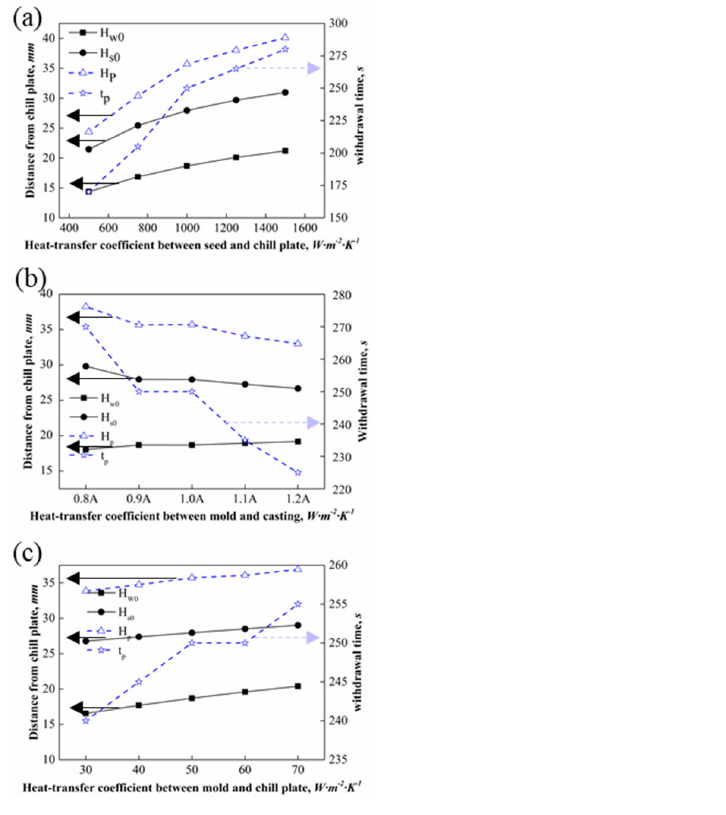
Figure 9. The effect of boundary conditions on the thermal profile of the seed segment: ( a ) the influence of heat transfer coefficient between the seed and the chill plate, ( b ) the influence of the heat transfer coefficient between the mold and the casting, and ( c ) influence of the heat transfer coefficient between the mold and the chill plate. H w0 refers to the distance between the liquidus temperature point on the mold (inner surface) and the bottom of the seed at the end of the holding stage. H s0 refers to the distance between the liquidus temperature point on the mold (inner surface) and the bottom of the seed at the end of the holding stage. At a withdrawal time of T p , the solidified interface morphology is transformed into a flat interface, and at the same time, the distance between the flat solidified interface between the bottom of the seed is H p